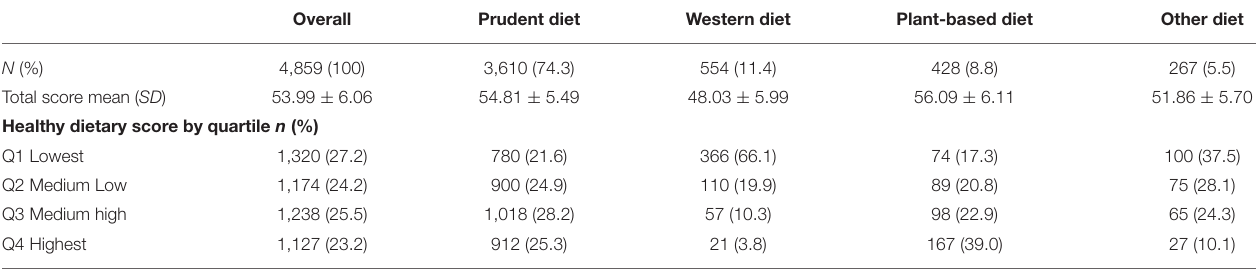
TABLE 5 | Dietary score according to different dietary patterns. Overall Prudent diet Western diet Plant-based diet Other